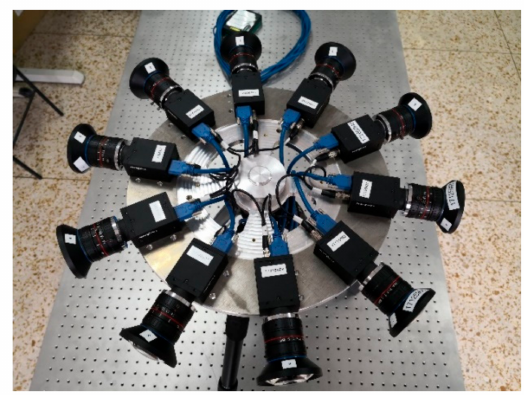
Figure 12. The binocular panoramic stereo imaging system.